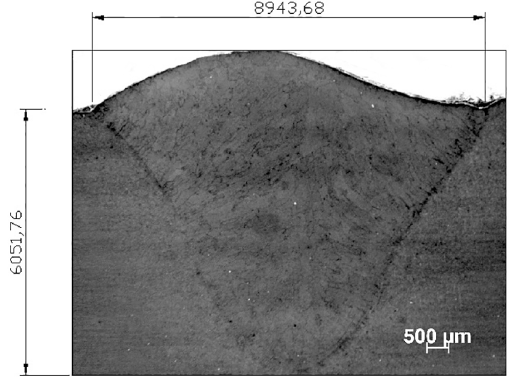
Figure 2. The Double-Ellipsoid Model or the GoldakSource 23 Table 3. Experimentally measured results of the thermophysical properties of API 5L X80 14 .